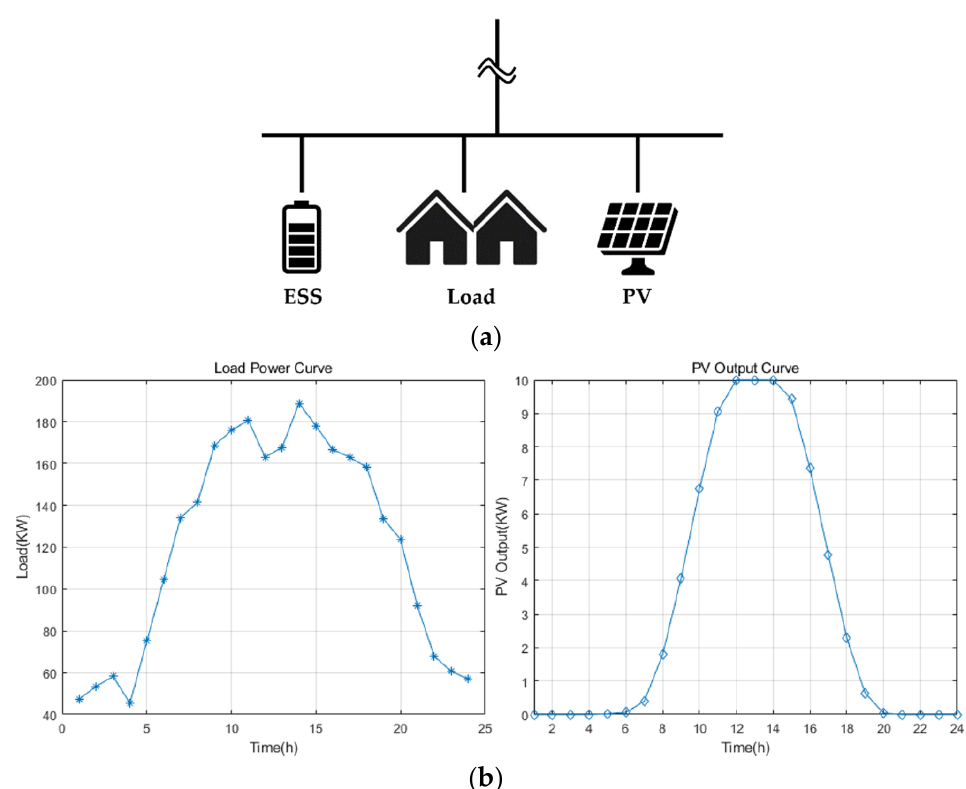
Figure 15. ( a ) The power system architecture; ( b ) The Load power curve and PV Output curve.